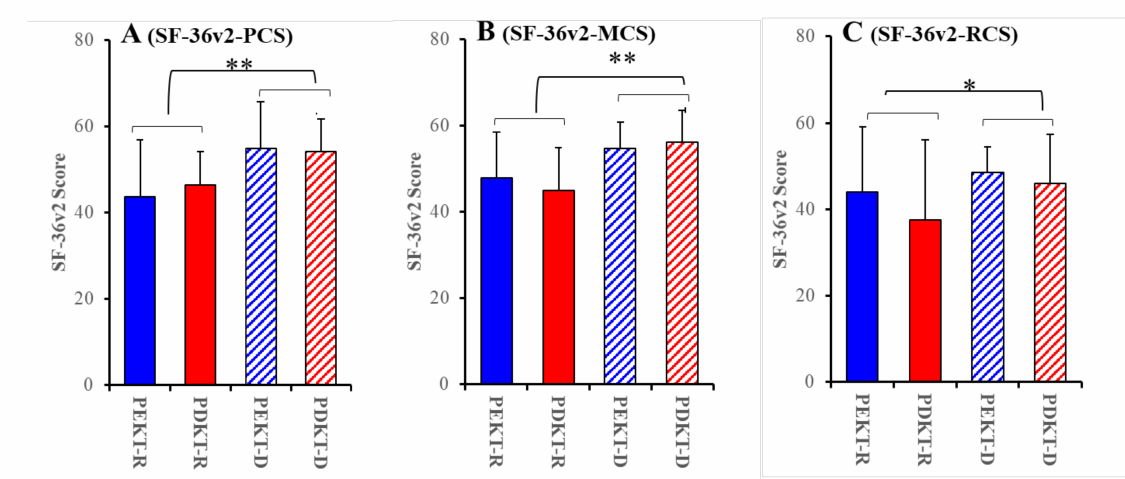
Figure 2. Comparisons of SF-36v2-PCS ( A ), SF-36v2-MCS ( B ), and SF-36v2-RSC ( C ) among PEKT recipients (PEKT-R), PDKT recipients (PDKT-R), PEKT donors (PEKT-D), and PDKT donors (PDKT-D) during kidney transplant decision-making. Ordinates indicate the mean SD for the scores of the SF-36v2 components. * p < 0.05, ** p < 0.01, relative to the SF-36v2 ± component scores of donors using a two-way analysis of variance (ANOVA) with Scheffe’s post-hoc test. Analyses between PEKT and PDKT were impossible since the F-values of the two-way ANOVA for the transplantation factor (PEKT vs. PDKT) and interaction factors (transplantation with relationship) were not violated ( p >